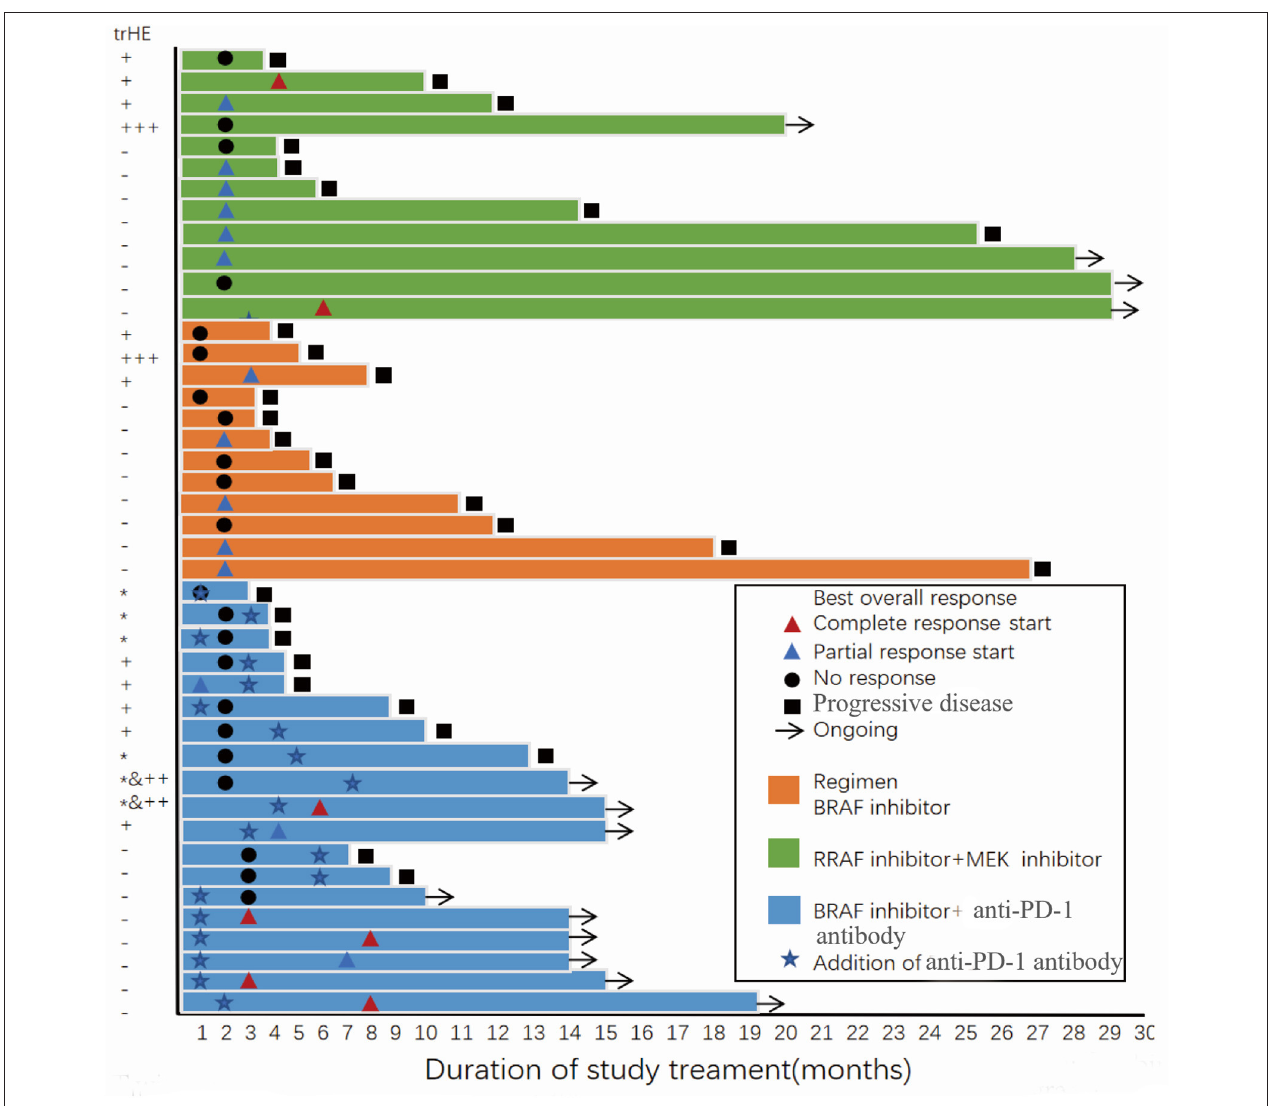
FIGURE 2 | Progression-free survival and best overall response of all patients in the two groups with or without treatment-related hepatotoxicity. trHE, treatment-related hepatotoxicity defined as the increase of either ALT, AST, or bilirubin levels; + , grade 1 increase of either ALT or AST level; + + + , grade 3 increase of either ALT or AST level; *, grade 1 increase of bilirubin; ++ &*, concomitant increase of bilirubin (grade 1) and either ALT or AST (grade